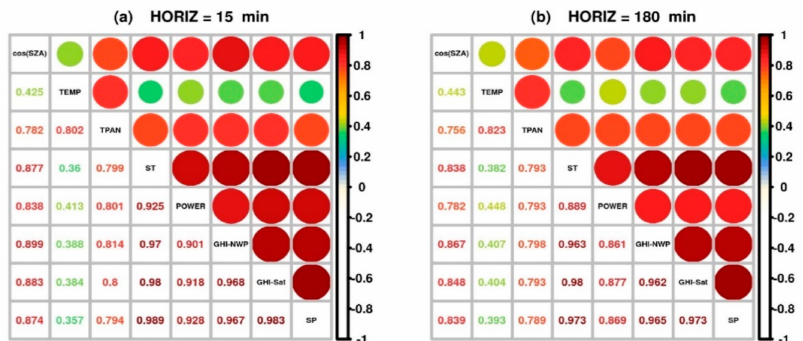
Figure 6. Correlogram between possible predictors and power measurements related to the forecast- ing horizon of 15 min ( a ) and 180 min ( b ) for the plant